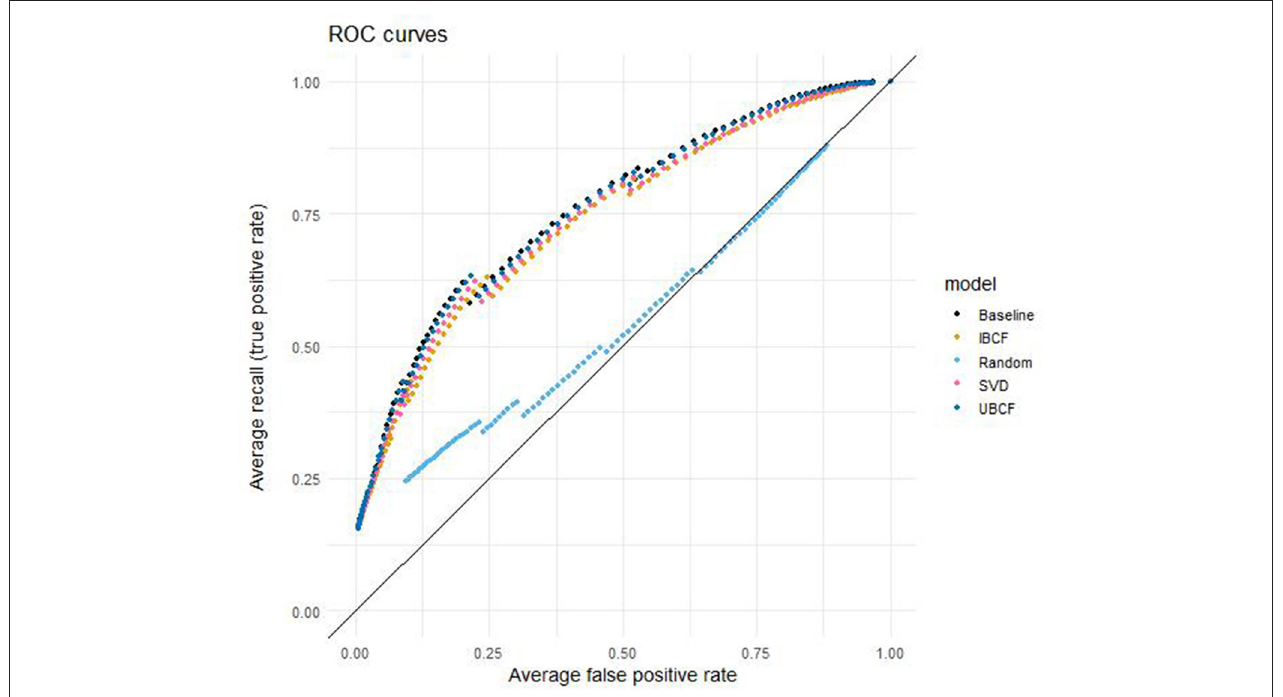
FIGURE 5 | False positive rate vs. recall (ROC curve) per model for different thresholds, averaged over students and cross-validation folds.